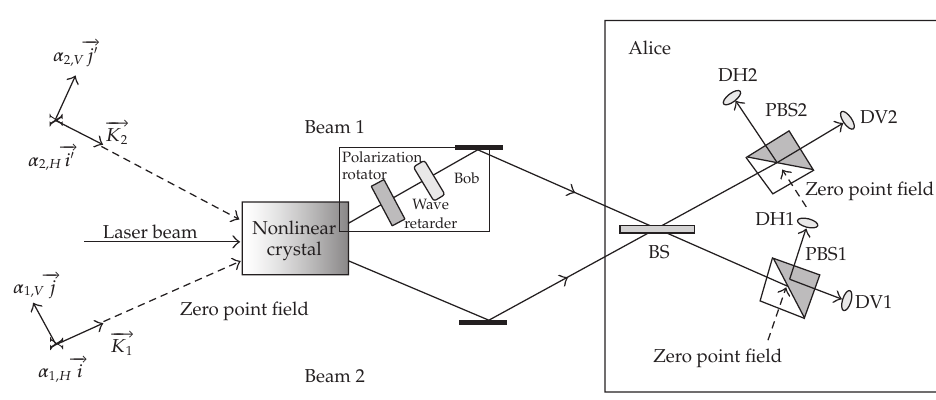
Figure 1: Setup for quantum dense coding. The polarization rotator and the wave retarder used by Bob allow a transmission to Alice of any of the Bell-states. Alice’s station consists on a balanced beam-splitter, two polaryzing beam-splitters, and detectors DH1, DV1, DH2, and DV2.